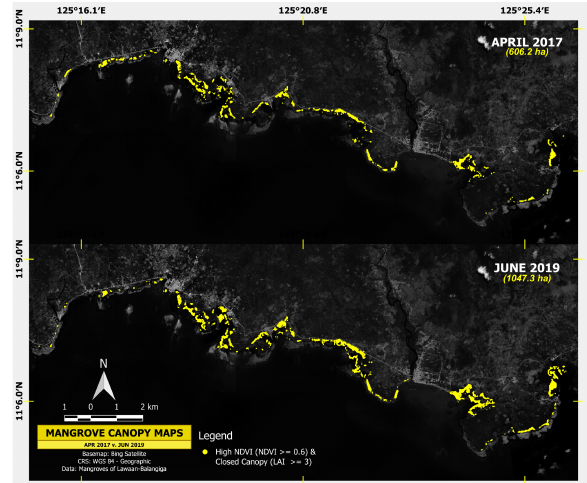
Figure 14. Mangrove canopy area maps (a) APRIL 2017